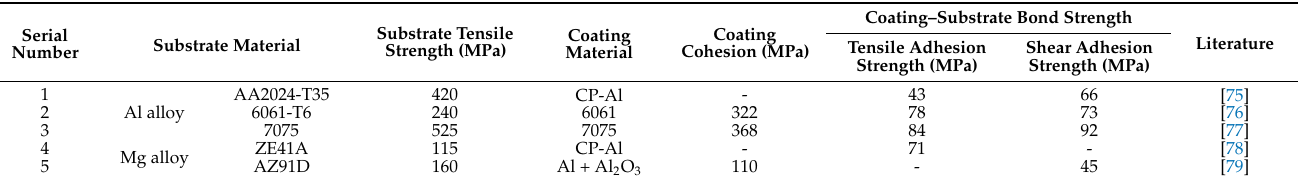
Table 3. Mechanical properties of cold-spray coatings on aluminum and magnesium